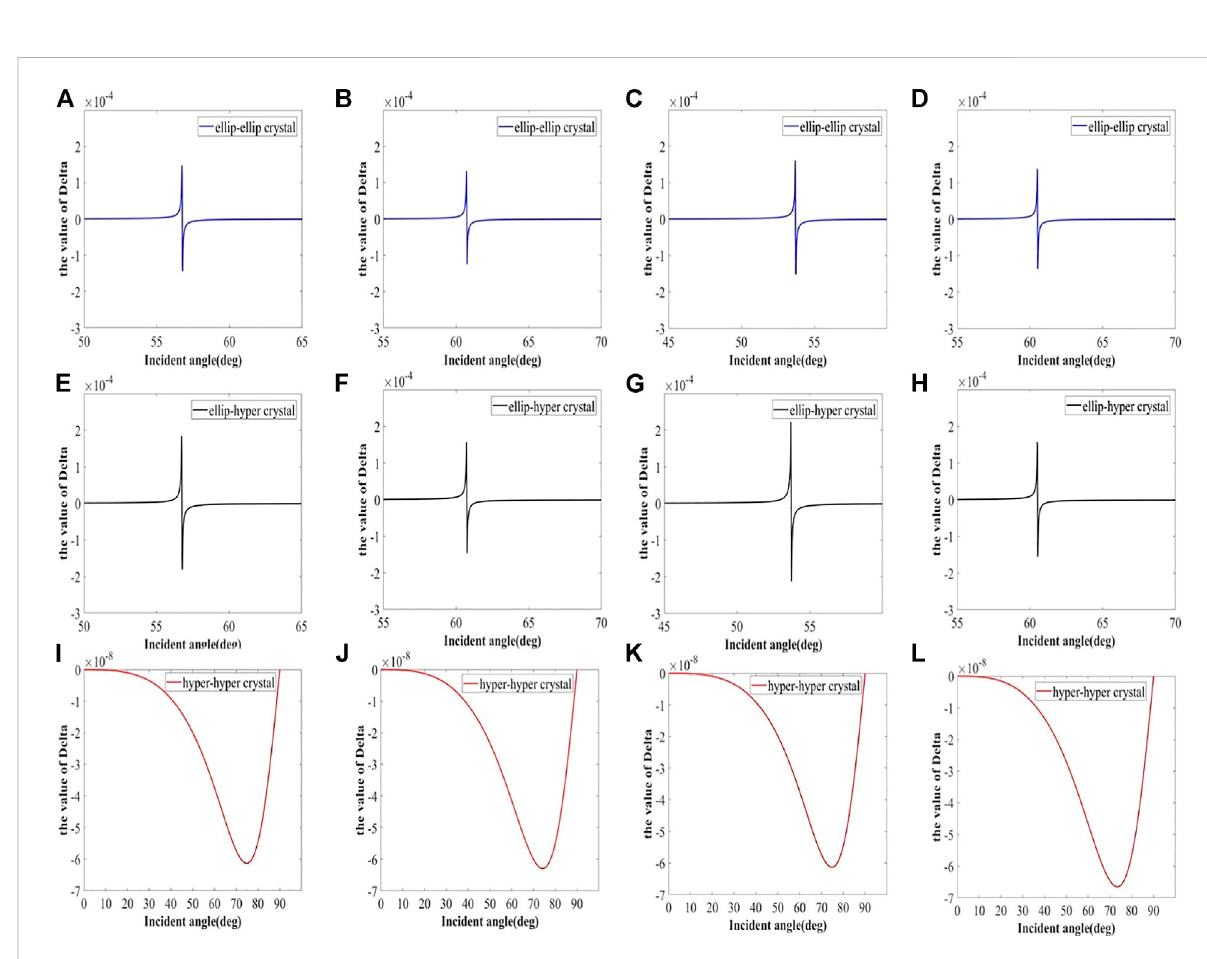
FIGURE 5 Distributions of spin splitting distance δ based on different uniaxial crystals of different index